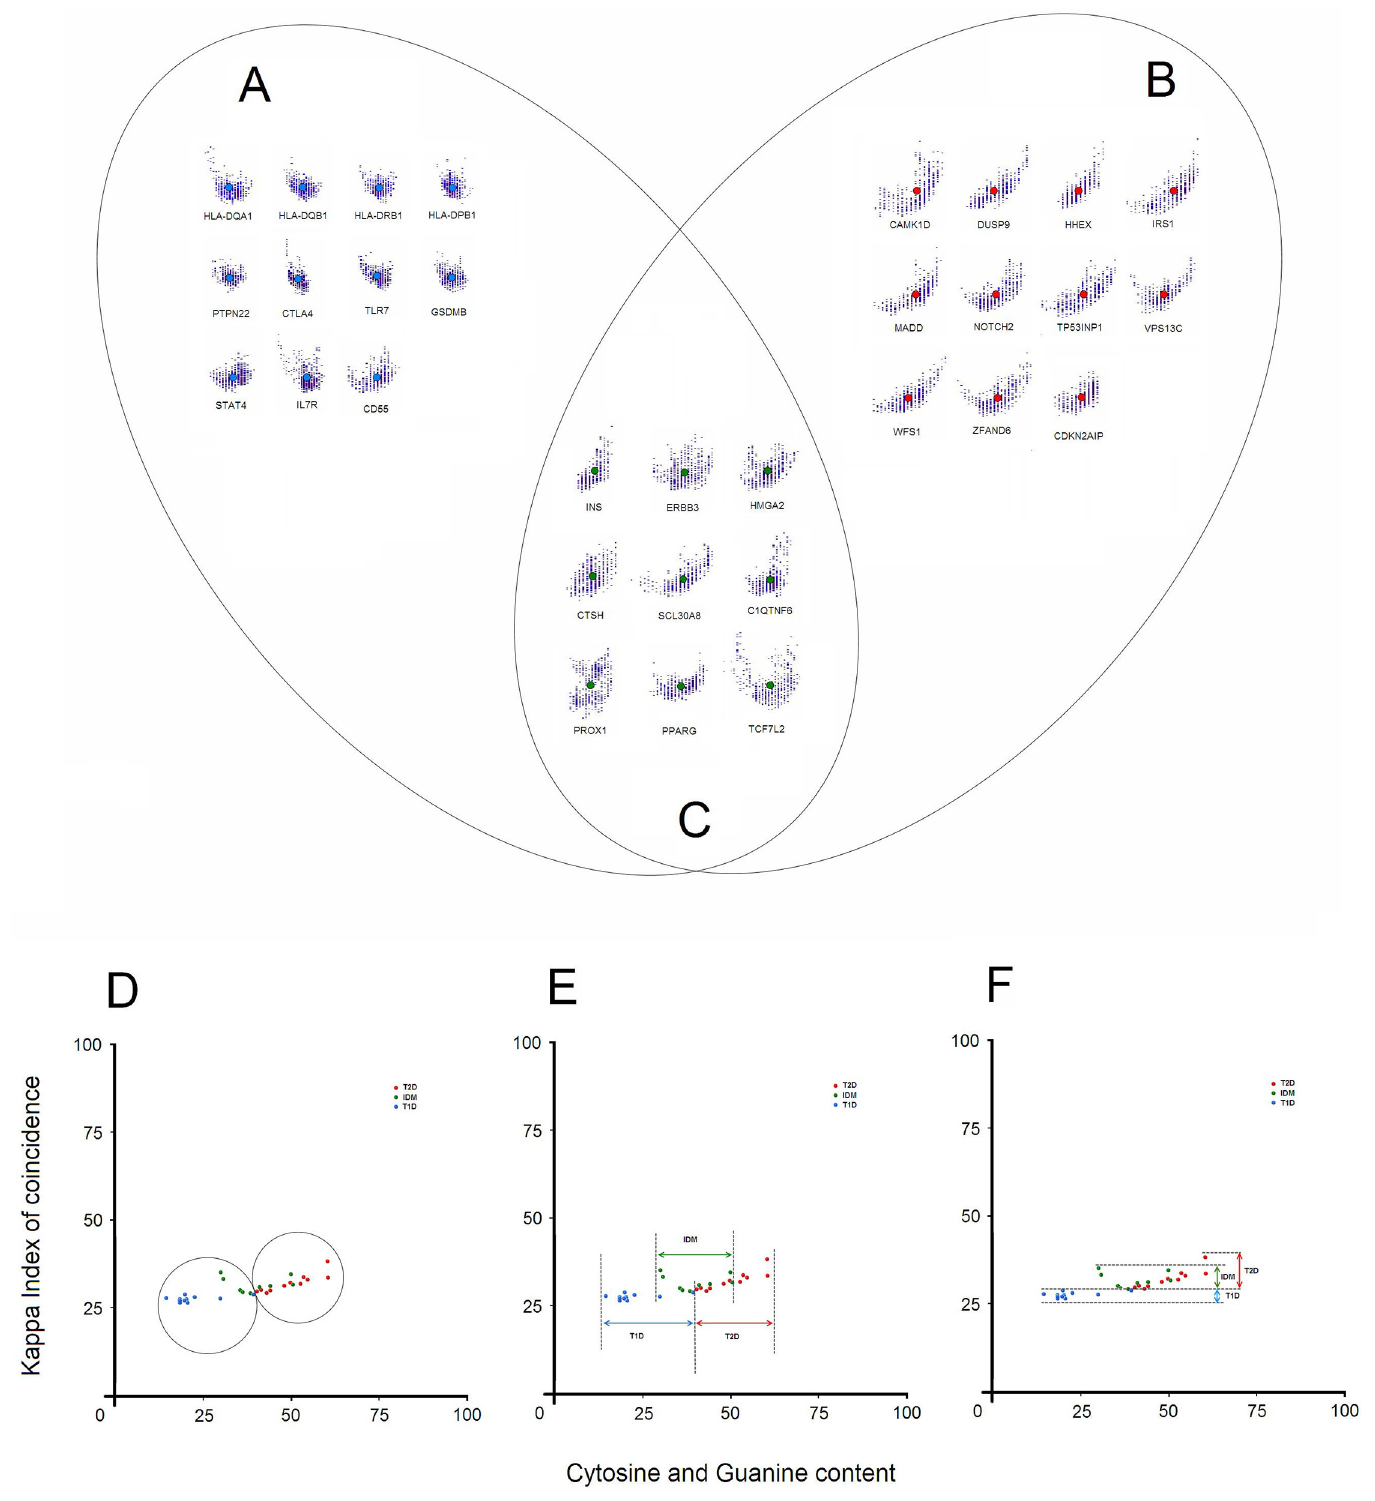
Fig 3. Redristribution of promoters according to T1D, IDM and T2D. (A) T1D promoters (blue dots), (B) T2D promoters (red dots) and (C) promoters from genes associated with the “ intermediary ” phenotype (green dots). (D) Full separation of T1D and T2D after the inclusion of the intermediary phenotype, (E) C +G values of intermediary phenotype areas overlapping equally in both T1D and T2D regions, (F) Kappa IC values of intermediary phenotype overlapping only with T2D areas. doi:10.1371/journal.pone.0137950.g003 PLOS ONE | DOI:10.1371/journal.pone.0137950 September 17,